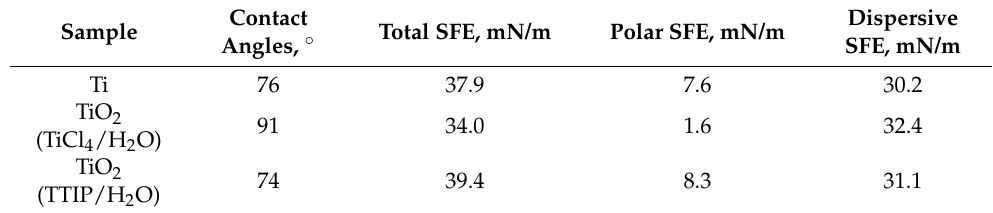
Table 2. Results of water contact angle measurements and surface free energy calculation.